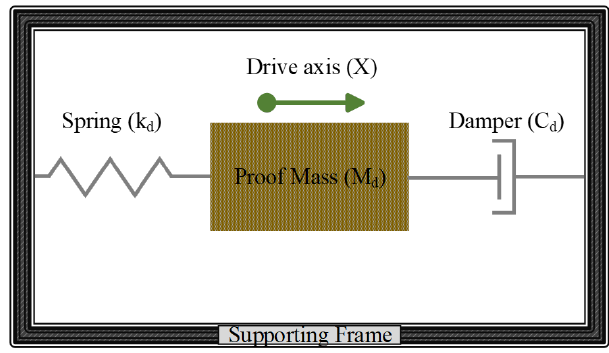
Figure 3. One degree of freedom (1-DOF) mass spring damper system.